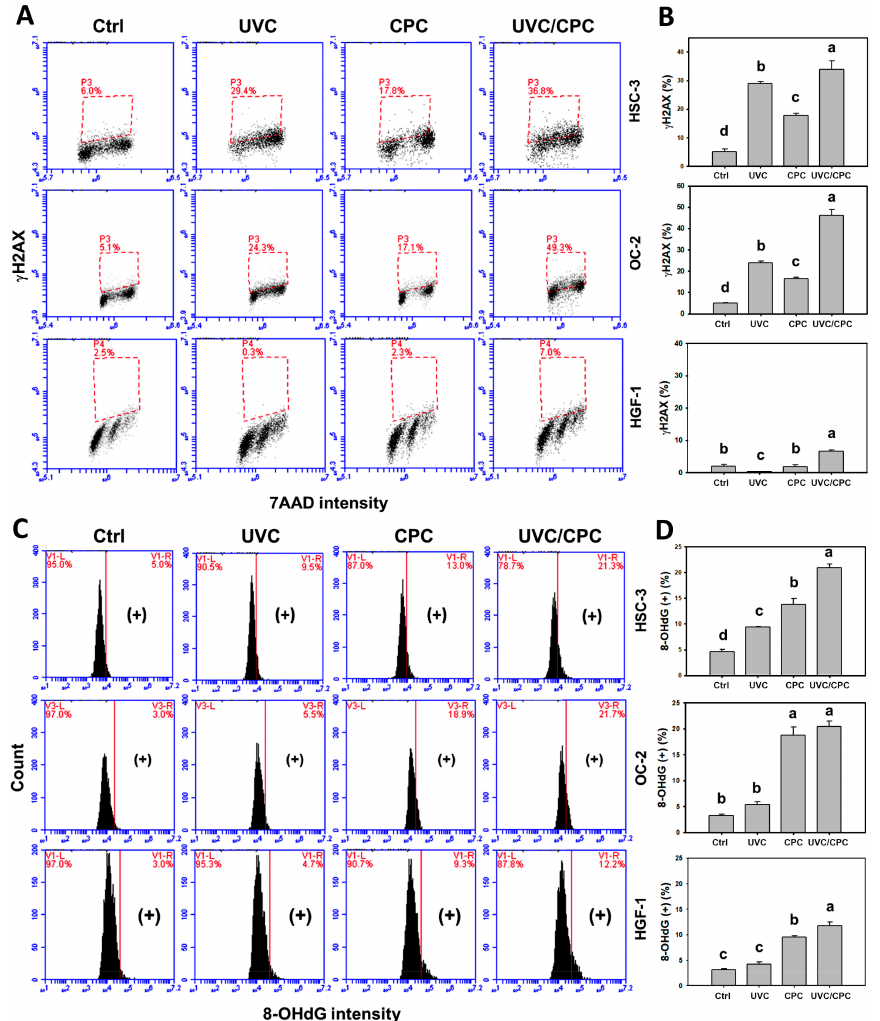
Figure 6. γ H2AX and 8-OHdG changes of oral cancer and normal oral cells following UVC and/or CPC treatments. Oral cancer (HSC-3 and OC-2) and oral normal (HGF-1) cells were arranged to treat with vehicle control, UVC (10 J/m 2 ), CPC (5 µ g/mL), and UVC/CPC (10 J/m 2 and 5 µ g/mL). Flow cytometry was performed after 24 h treatment. γ H2AX (+) and 8-OHdG (+) populations were arranged with trapezoid and labeled with (+), respectively, i.e., + for high intensity. ( A ) γ H2AX pattern. ( B ) Statistics ( A ). ( C ) 8-OHdG patterns. ( D ) Statistics in ( C ). Data, mean ± SD ( n = 3). Based on multiple comparisons after Tukey’s HSD Tests, different tests labeling without the same top letters differ significantly ( p <